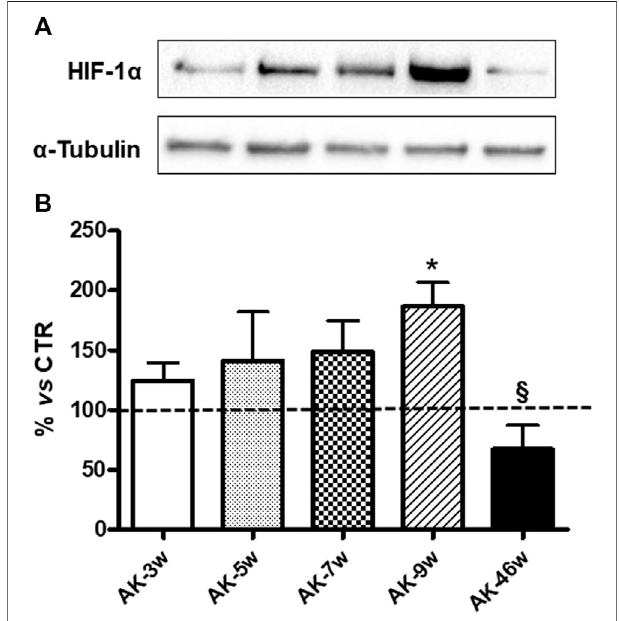
FIGURE 4 | HIF-1 α protein levels in Ins2 Akita mice at different ages. (A) : Representative western blottings of HIF-1 α and the respective α -tubulin, measured in the same samples, of total homogenates of retinae from Ins2 Akita (AK) mice at different ages (w (cid:2) weeks). (B) : Densitometric analysis of HIF-1 α immunoreactivities in the total homogenates of retinae from wild-type and AK mice at different ages. Alpha-tubulin was used as a loading control. Results are expressed as % ( ± S.E.M.) vs control wild-type (100%, dashed line). * p < 0.05 vs wild-type and § p < 0.05 vs AK-9w; Tukey ’ s Multiple Comparison post-hoc test, n (cid:2) 8 – 10.